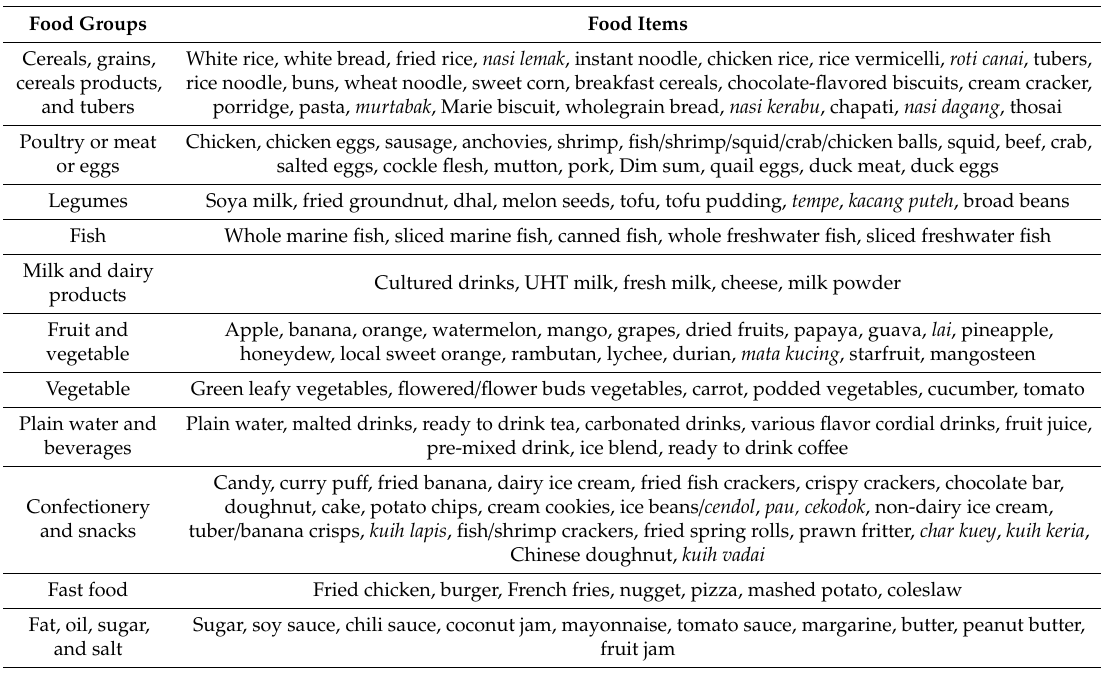
Table 2. Food groups and food items in Food Frequency Questionnaire